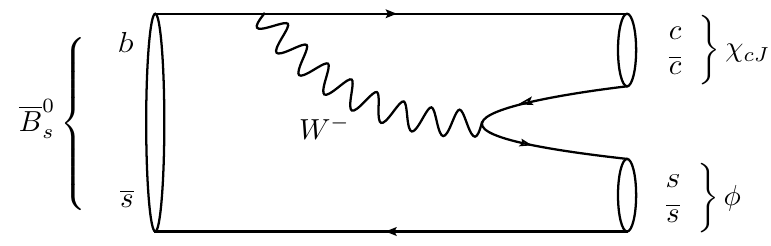
Figure 1 . Tree-level Feynman diagram for the B 0